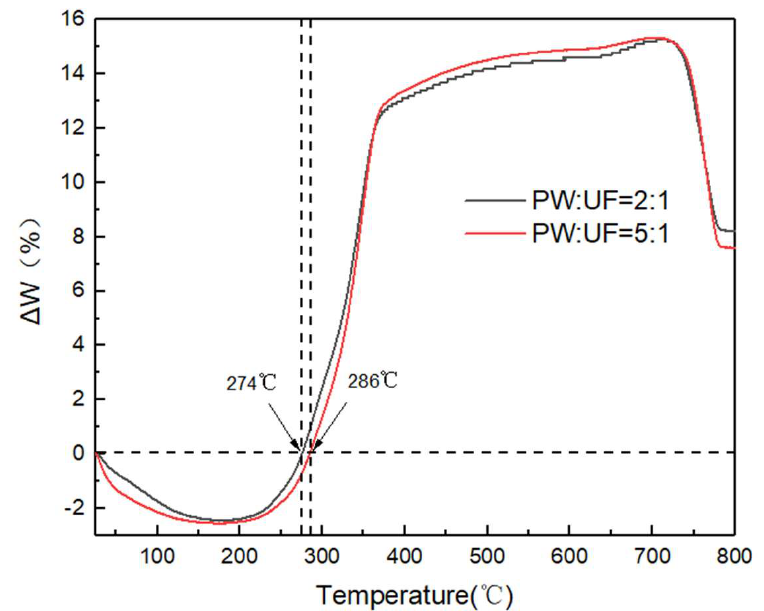
Figure 2. ∆ W of blended pellets with different Figure 2. ∆𝑊 of blended pellets with different proportions.